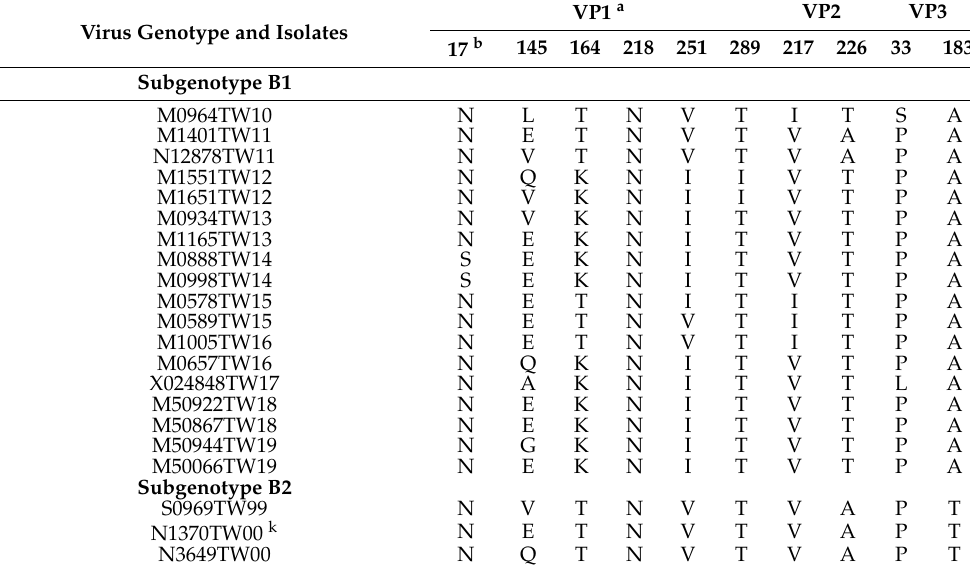
Table 1. Cont. Virus Genotype and